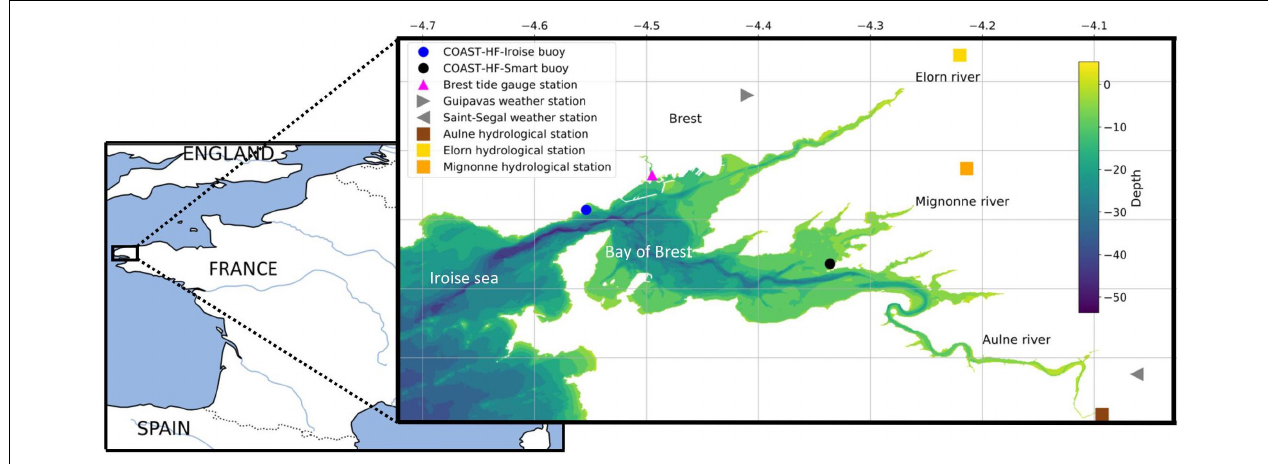
FIGURE 1 | The study area (black square) is located in the western part of France. The COAST-HF-Iroise buoy (blue circle) is at the interface between the Iroise Sea (Atlantic) and the Bay of Brest. The COAST-HF-Smart (black circle) is more inland, in the eastern part of the Bay of Brest. The Brest tide gauge station (pink triangle), and weather (grey triangles) and hydrological (coloured squares) stations are indicated.